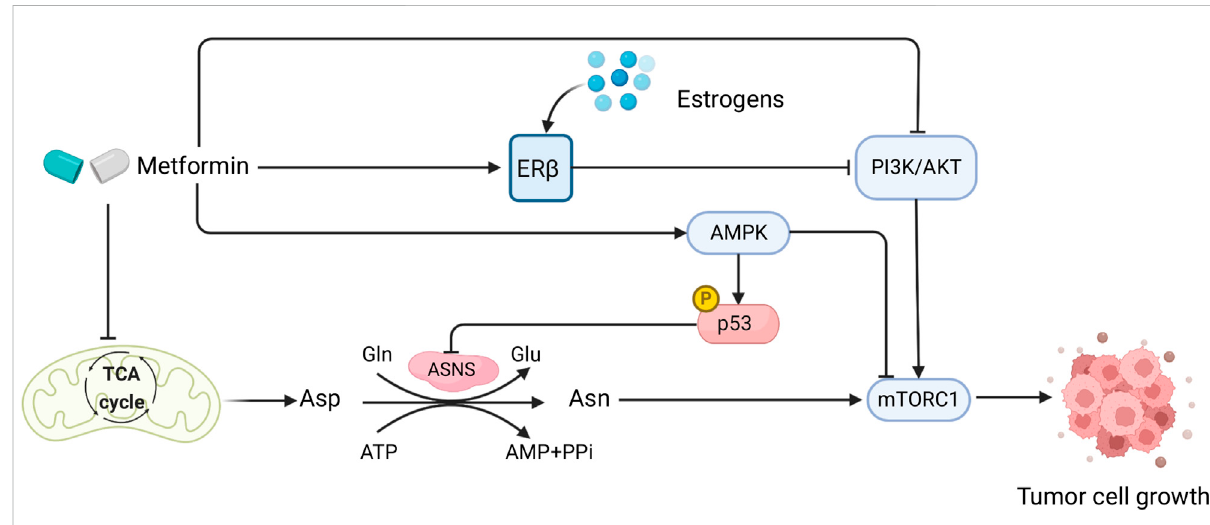
FIGURE 3 Sex interacts with the effect of metformin in CRC patients and mediates Asn metabolism. Created with